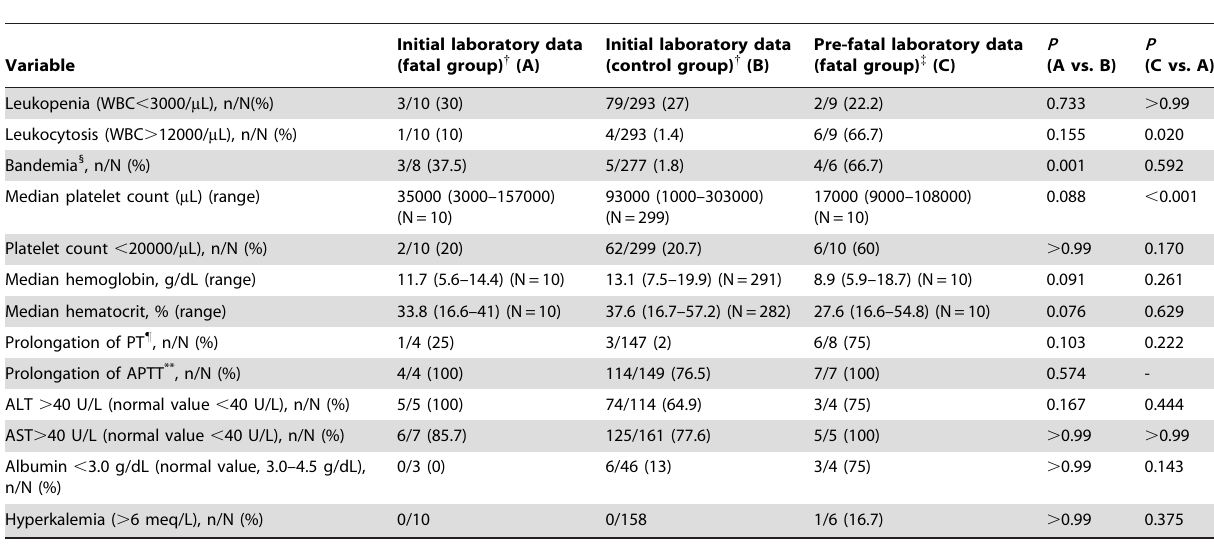
Table 2. Laboratory information of the fatal and control